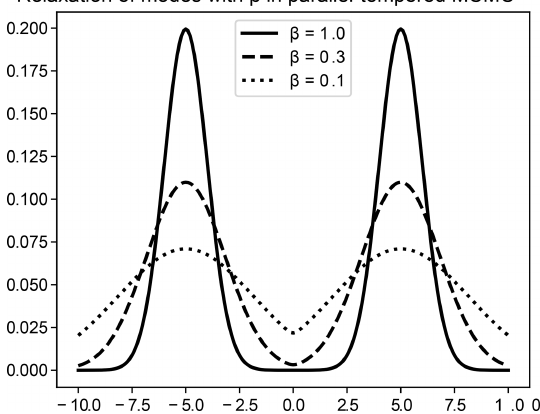
Figure 1. Parallel-tempered relaxation of a bimodal distribution.